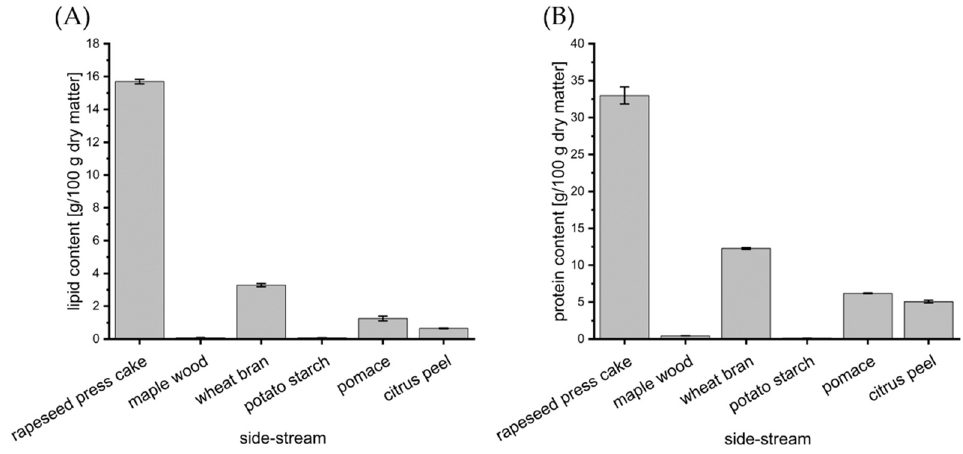
Figure 4. Lipid ( A ) and protein content ( B ) of side-streams used as medium supplements for the cultivation of Cerrena unicolor .